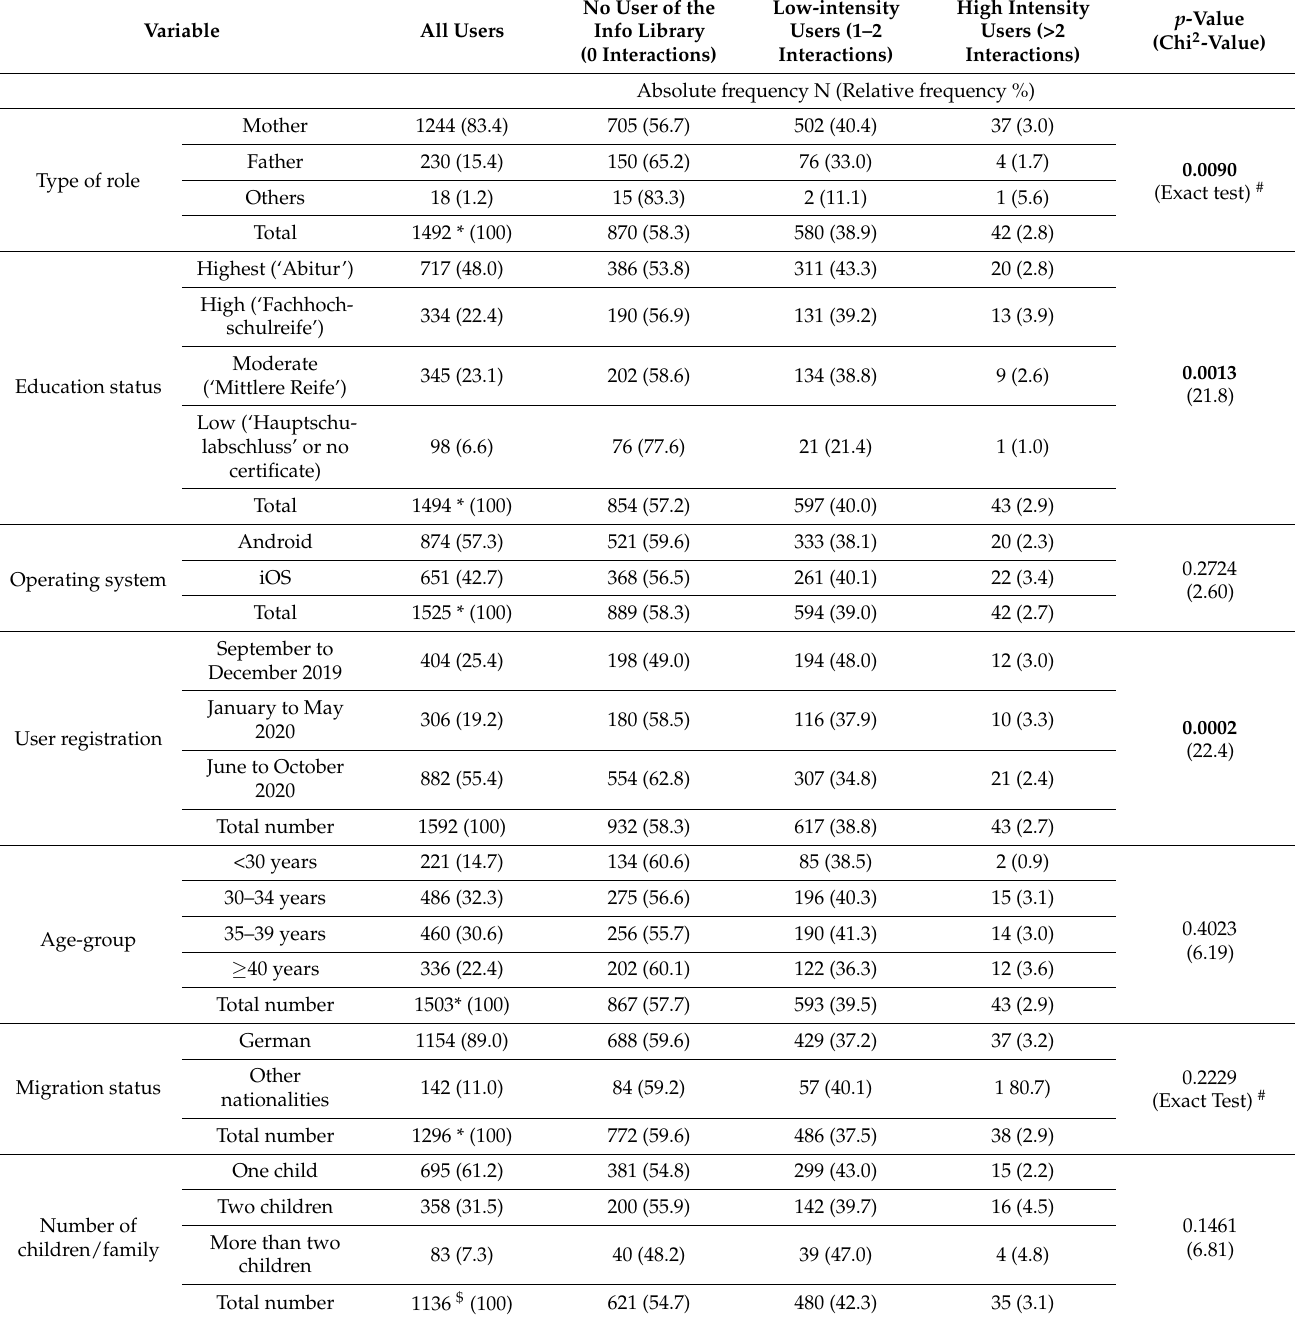
Table 1. Viewing the opening